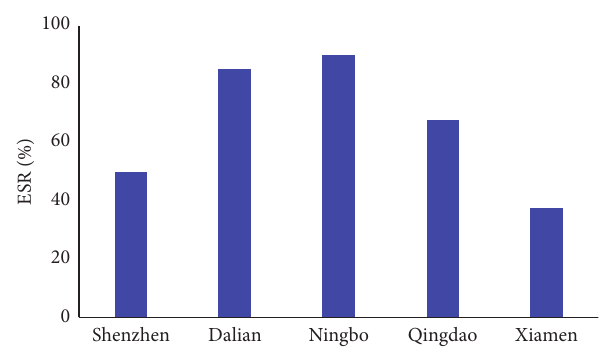
Figure 2: ESR of each city in 2017.